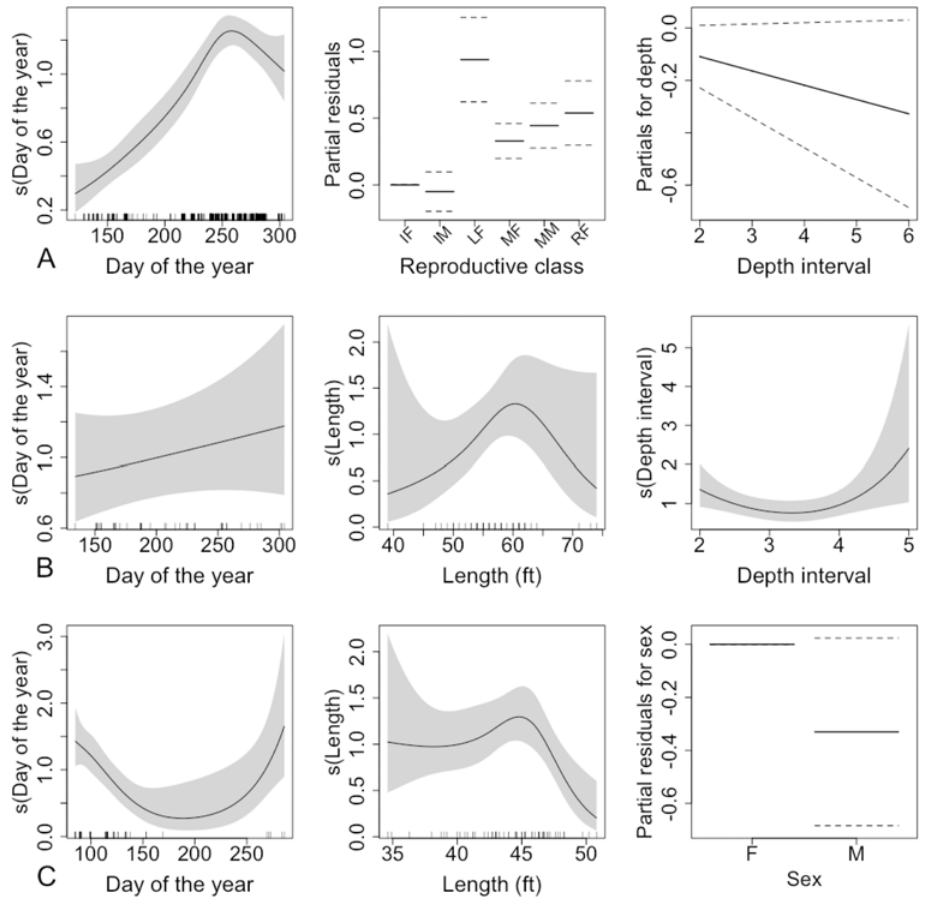
variable for reproductive class plotted against the partial residuals for that variable, and a linear term for depth interval; for fin whales (B) a linear term for day of the year and smooth terms for body length and